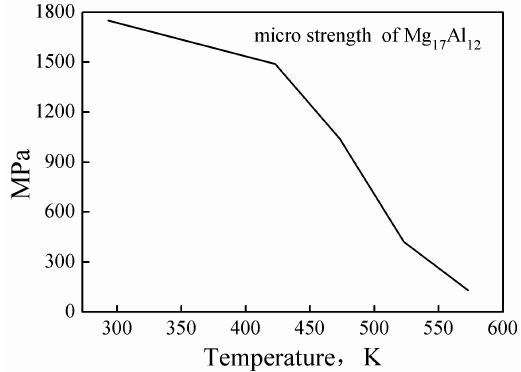
Figure 10. Permanent microscopic strength values of the Mg 17 Al 12 phase at different temperatures. [37].